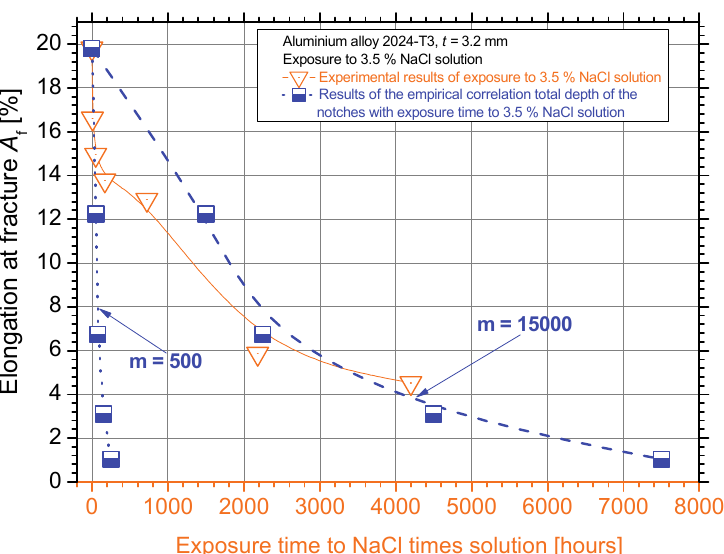
Figure 8: Correlation of the elongation at fracture A f decrease due to exposure to the 3.5 wt. % NaCl solution as well as to the presence of the artificial surface